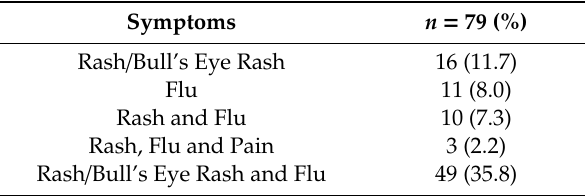
Table 2. Anticipated early symptoms of Lyme